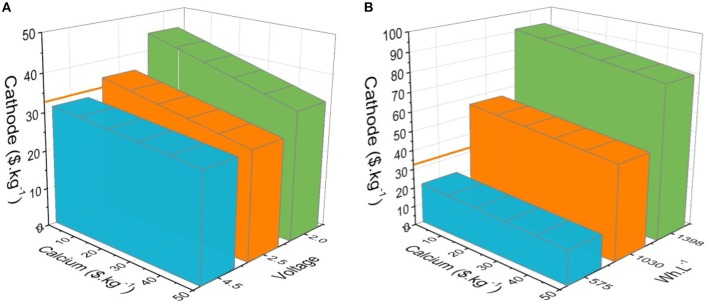
Cost-effectiveness of estimated CaBs with cathode capacities of 100 (blue), 200 (orange), and 300 (green) mAh.g−1 vs. a reference NMC/graphite cell (110 $.kWh−1) taken as areas representing the costs of both cathode and anode (Ca metal), allowing a total cell cost equal to or lower than 110 $.kWh−1 for: (A) CaBs with energy densities similar to or higher than NMC/graphite, and (B) with an operation potential of 3.5 V, identical to NMC/graphite. The orange line represents the NMC price proposed by Berg et al. (33 $.kg−1).